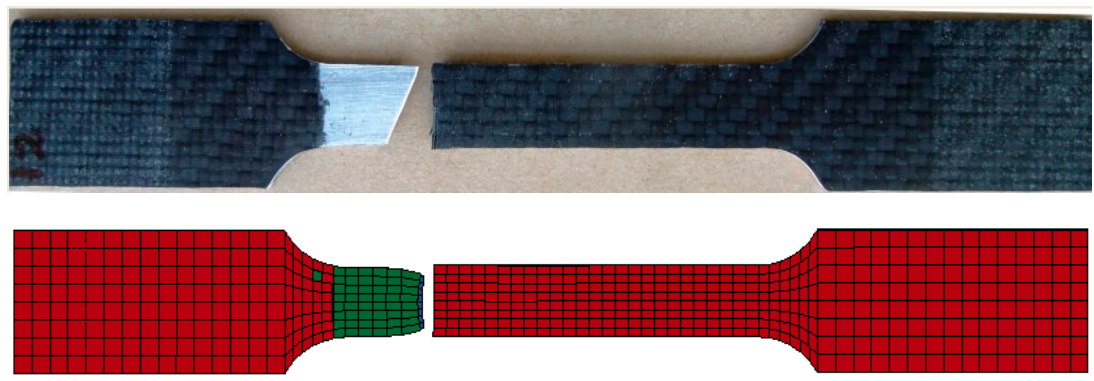
Figure 29. FEA and experimental failed specimen of CARALL-A with no veil cloth.